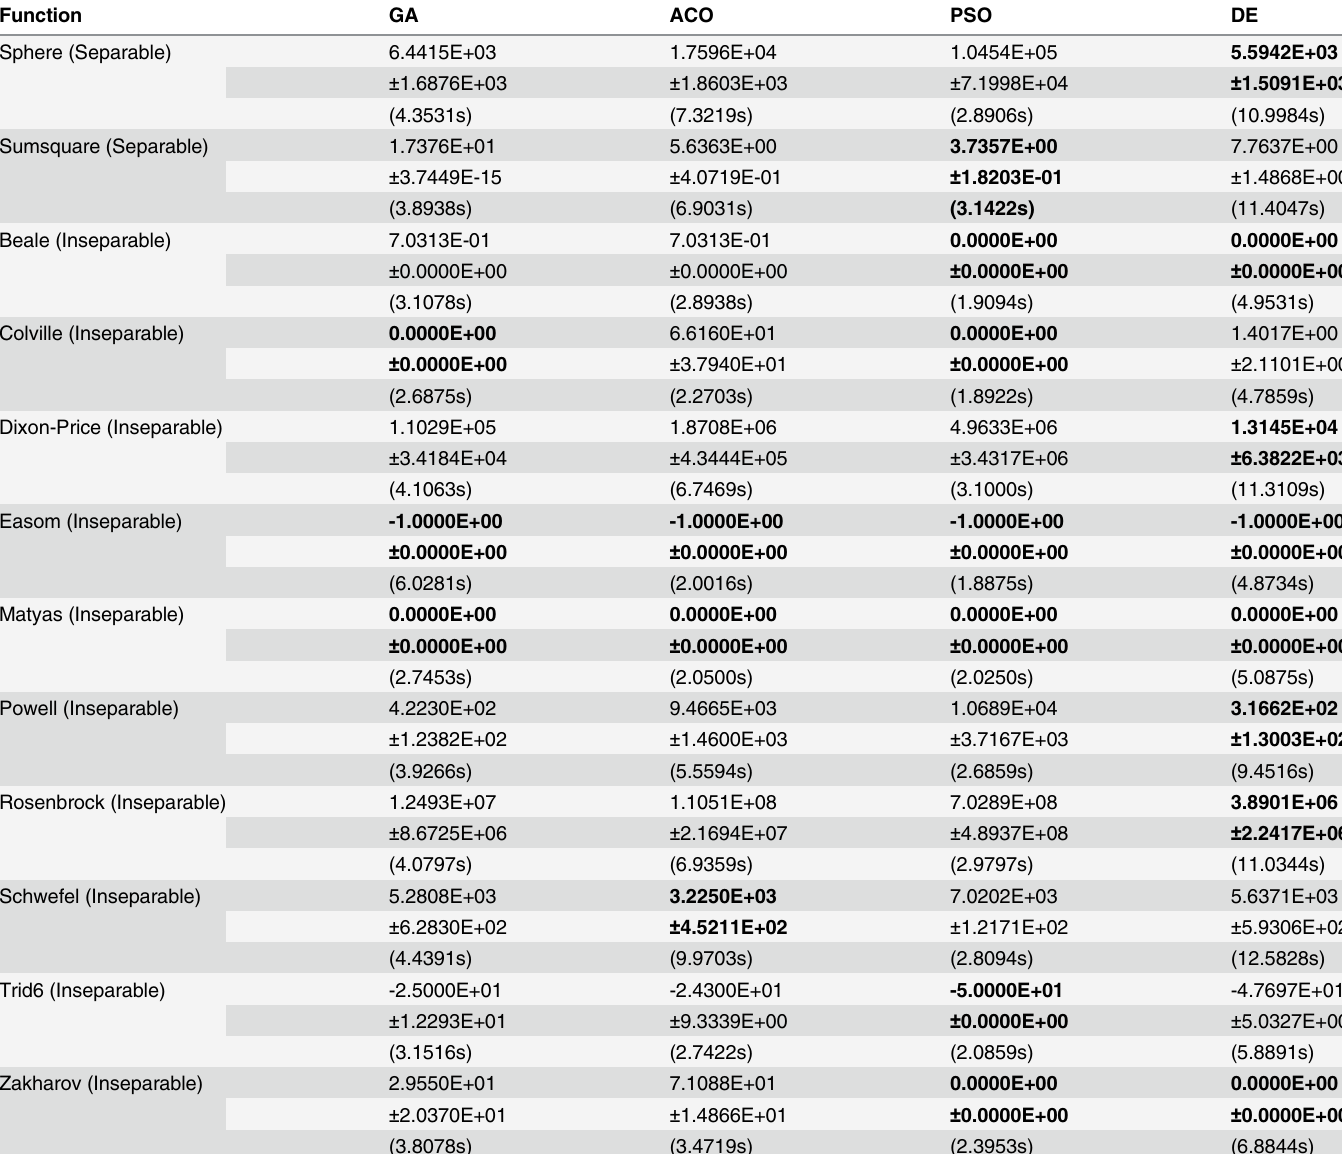
Table 3. Benchmark Functions Comparison of mean error (Mean ± SD) and time (Seconds) on Several Optimization Techniques. Function GA ACO PSO DE